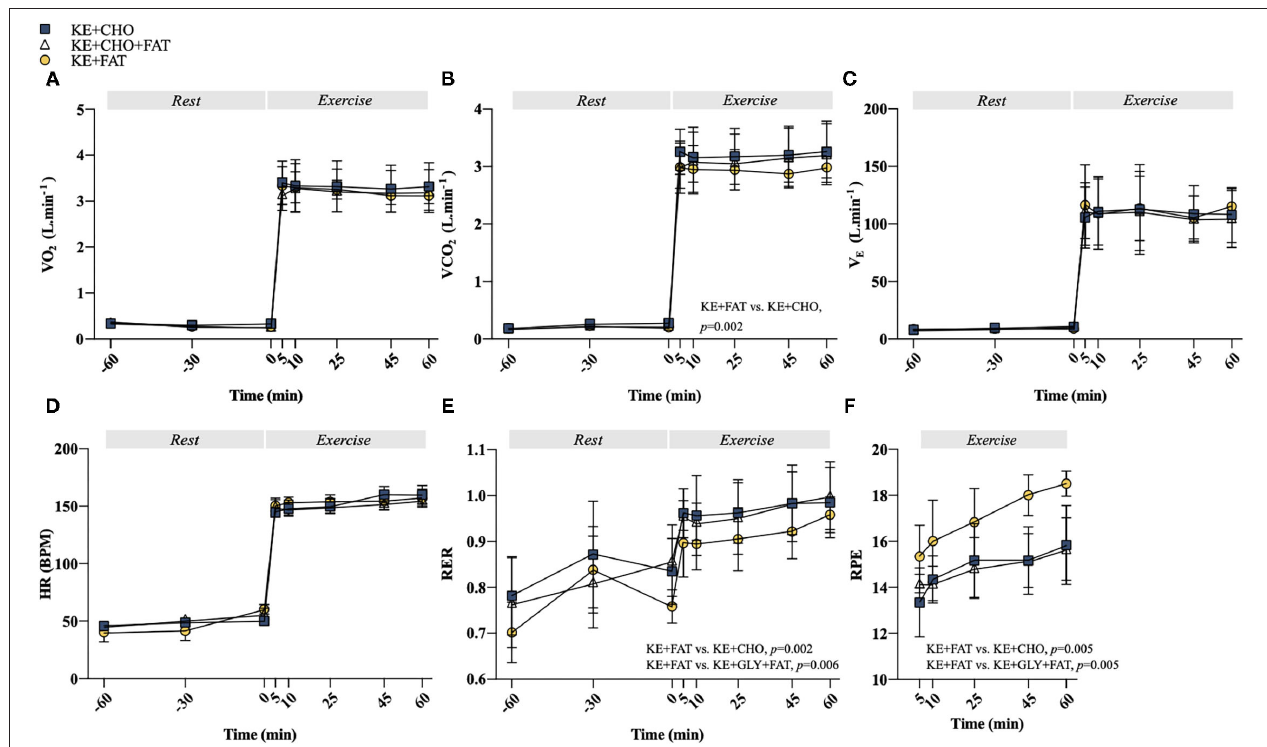
FIGURE 4 | Cardiorespiratory and exertion measurements. (A) Volume of oxygen consumed (VO 2 ) at rest and during exercise. (B) Volume of carbon dioxide expelled (VCO 2 ) at rest and during exercise. (C) Ventilatory exchange (V E ) at rest and during exercise. (D) Heart rate (HR) at rest and during exercise. (E) Respiratory exchange ratio (RER) at rest and during exercise. (F) Ratings of perceived exertion (RPE) at rest and during exercise. Values = mean ± SD.